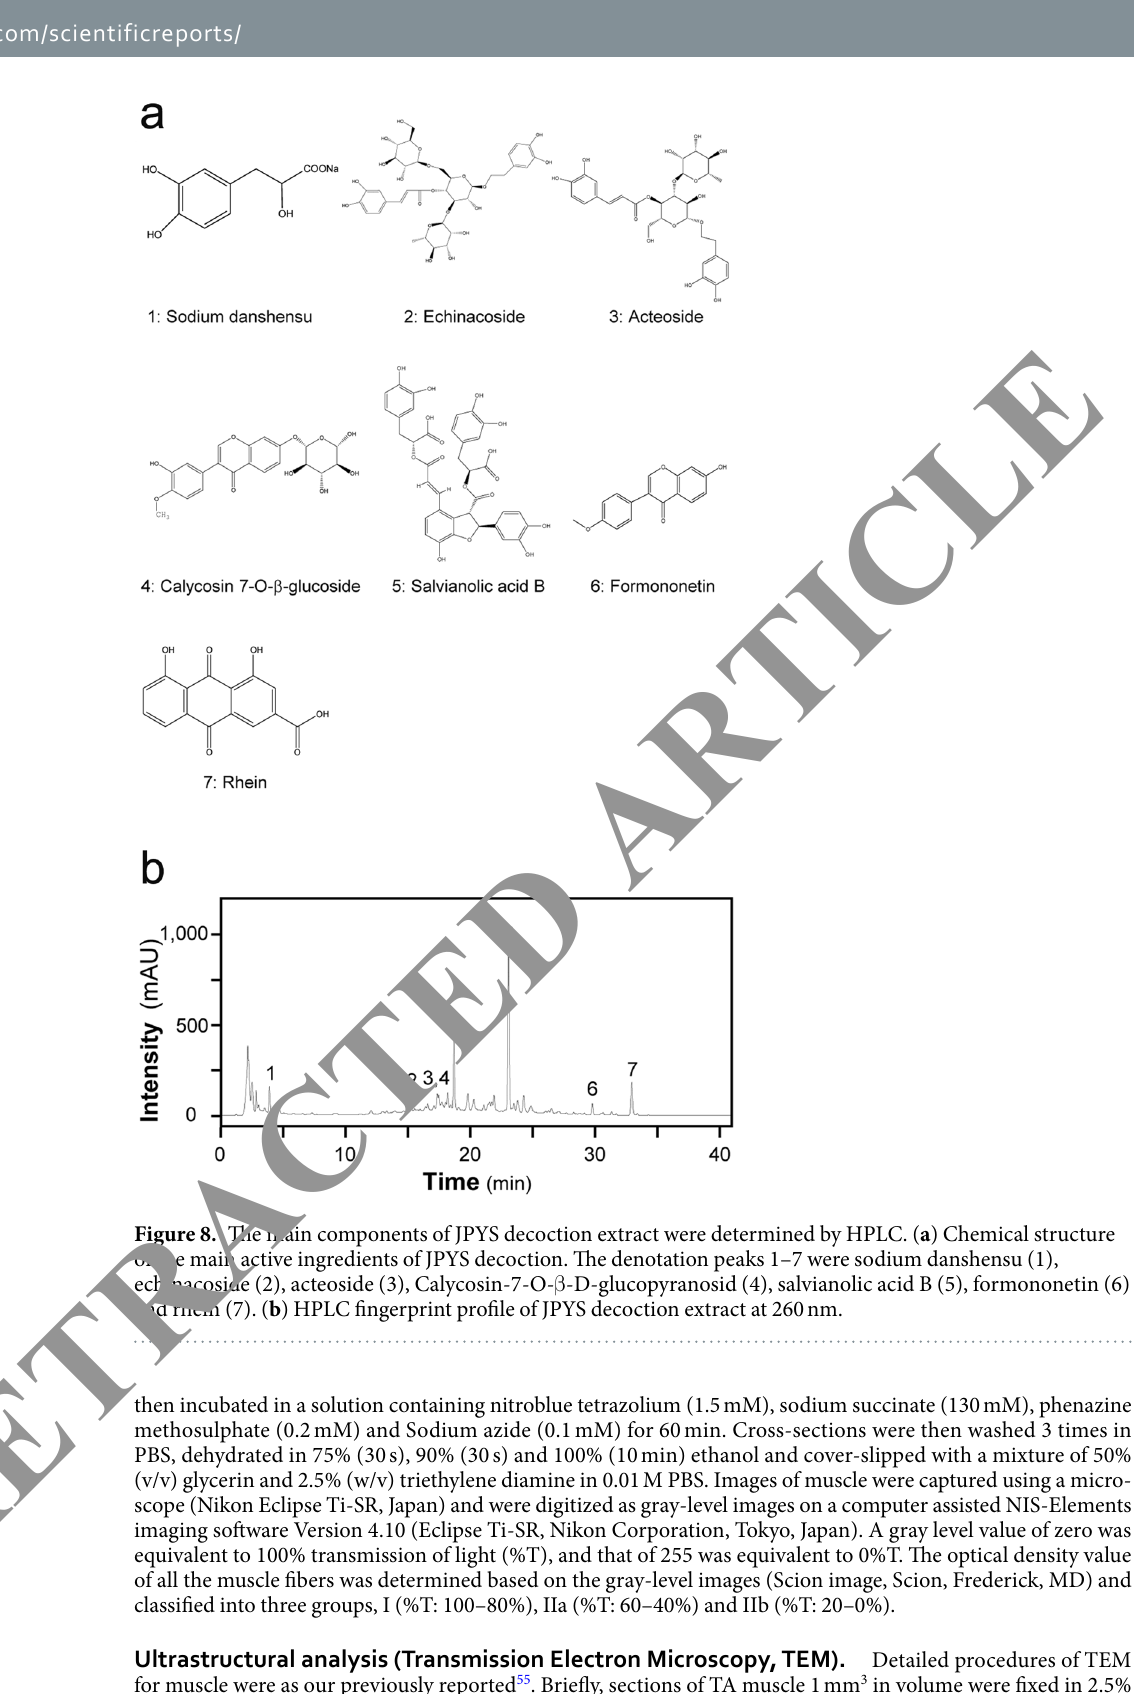
then incubated in a solution containing nitroblue tetrazolium (1.5 mM), sodium succinate (130 mM), phenazine methosulphate (0.2 mM) and Sodium azide (0.1 mM) for 60 min. Cross-sections were then washed 3 times in PBS, dehydrated in 75% (30 s), 90% (30 s) and 100% (10 min) ethanol and cover-slipped with a mixture of 50% (v/v) glycerin and 2.5% (w/v) triethylene diamine in 0.01 M PBS. Images of muscle were captured using a micro- scope (Nikon Eclipse Ti-SR, Japan) and were digitized as gray-level images on a computer assisted NIS-Elements imaging software Version 4.10 (Eclipse Ti-SR, Nikon Corporation, Tokyo, Japan). A gray level value of zero was equivalent to 100% transmission of light (%T), and that of 255 was equivalent to 0%T. The optical density value of all the muscle fibers was determined based on the gray-level images (Scion image, Scion, Frederick, MD) and classified into three groups, I (%T: 100–80%), IIa (%T: 60–40%) and IIb (%T: 20–0%). Ultrastructural analysis (Transmission Electron Microscopy, TEM). Detailed procedures of TEM for muscle were as our previously reported 55 . Briefly, sections of TA muscle 1 mm 3 in volume were fixed in 2.5% glutaraldehyde followed by postfixation in 1% osmic acid for the assays of electromicroscopy. Image J software was used to analyze images collected by EM (JEM-1400, JEOL Ltd.,Tokyo, Japan) under x12,000 magnifica- tion. Mitochondrial content was determined by quantifying the number and the size (minimum diameter) of each mitochondria per field. A total of 20 fields per condition were analyzed by taking advantage of the Image J software 56 .